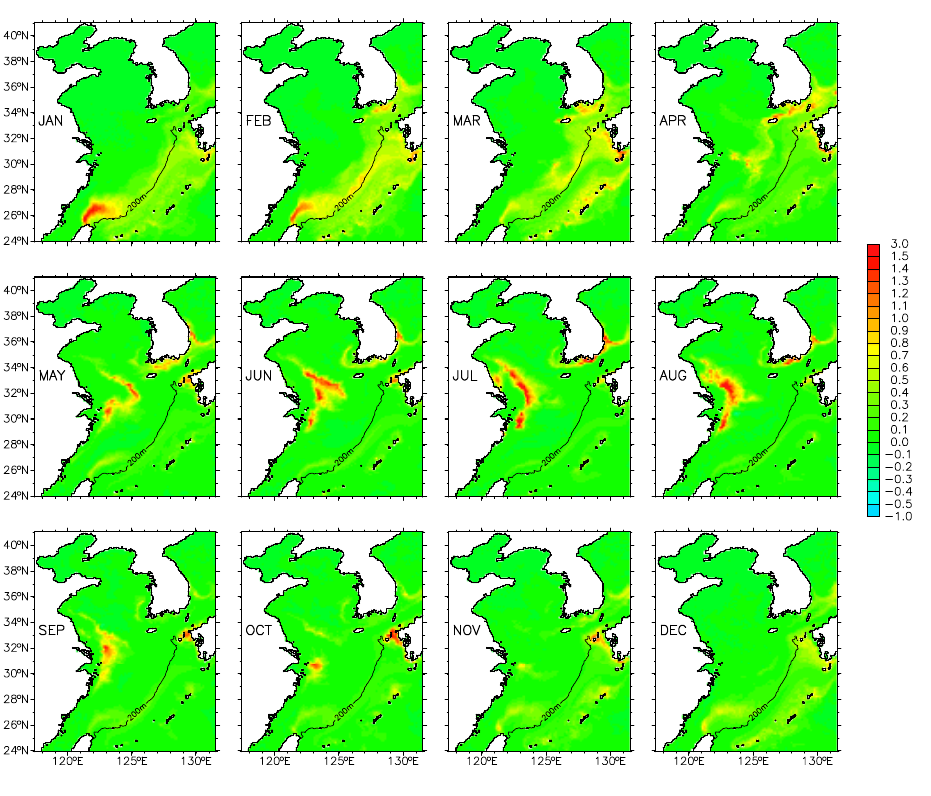
Fig. 14. The same as Fig. 12 but for chlorophyll a (mgm − 3 ) in the surface layer.